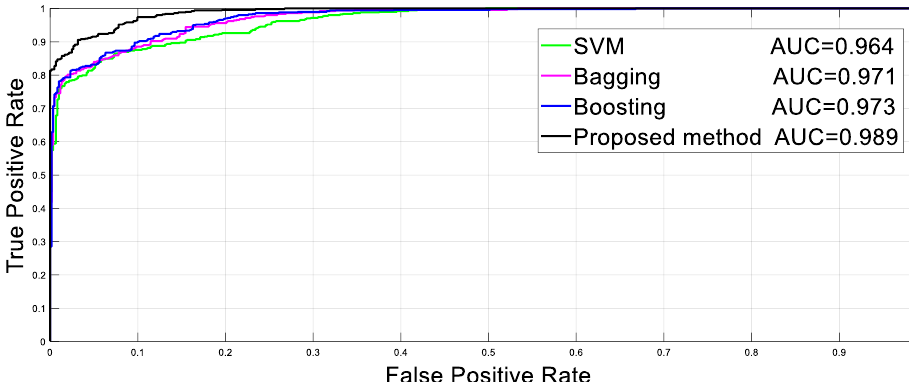
Figure 8. ROC curves of different detection methods.